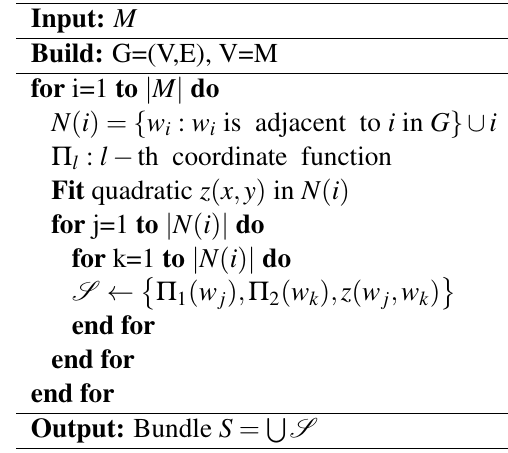
Table 1 The procedure to obtain the bundle of (cid:51) -smooth surfaces on M